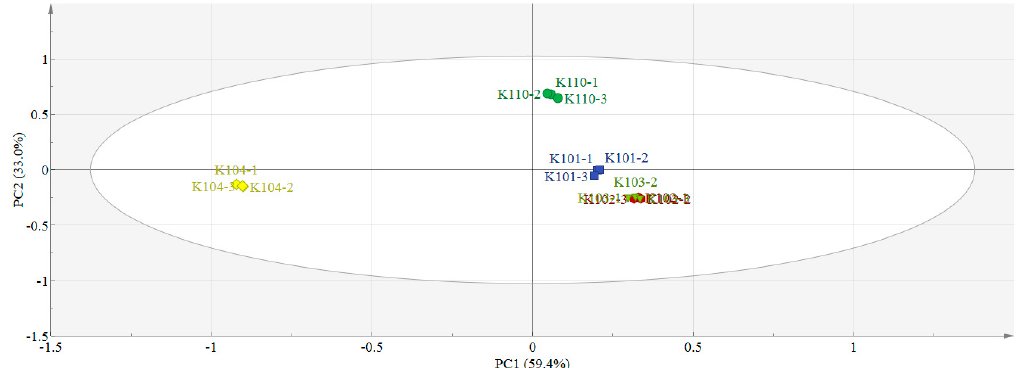
Figure 1. 143 variables-based principal component analysis (PCA) of 5grades Nongxiang Tieguanyin: PCA score plot of principal component 1 (PC1) versus principal component 2 (PC2) scores. The tea samples are located at the distinct positions in two-dimensional space described by two vectors of PC1 = 59.4% and PC2 = 33.0%.